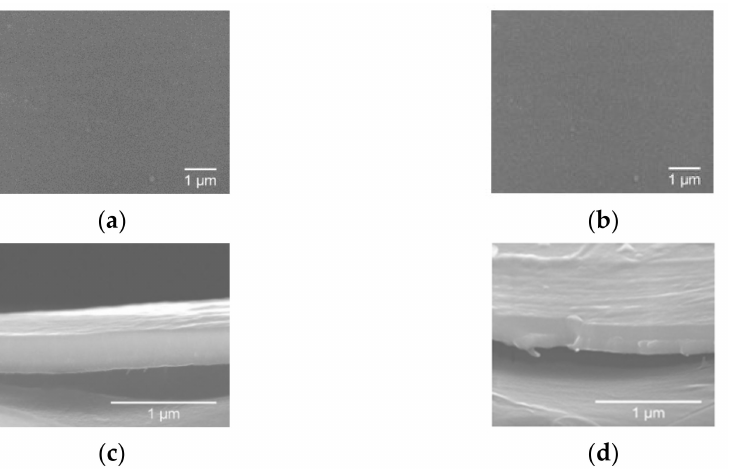
Figure 7. Surface SEM images of the second series of MoO x films grown on polyethylene terephthalate with indium tin oxide (PET-ITO) substrate with ( a ) 0.56 O 2 /Ar-30 min; ( b ) 0.56 O 2 /Ar-15 min. Cross- section SEM images of the second series of MoO x films grown on polyethylene terephthalate with indium tin oxide (PET-ITO) substrate with ( c ) 0.56 O 2 /Ar-30 min; ( d ) 0.56 O 2 /Ar-15 min. Table 3. Samples thickness calculated using RBS fit results and considering different molybdenum oxides and density estimation considering the thickness measured by SEM.